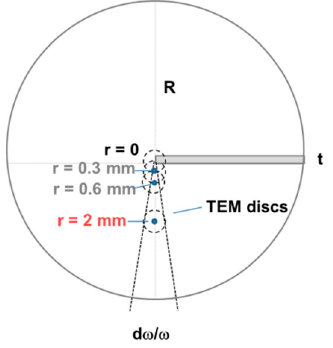
Figure 1. Not to scale scheme of HPT showing the location of extraction of the TEM discs; red label refers to OFHC Cu, grey labels refer to 6N-Al. The blue solid circle depicts the electron transparency area of the TEM discs.